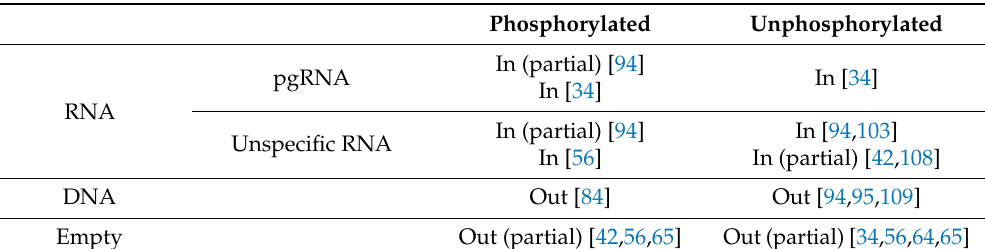
Table 1. Di ff erent localizations of the CTD.